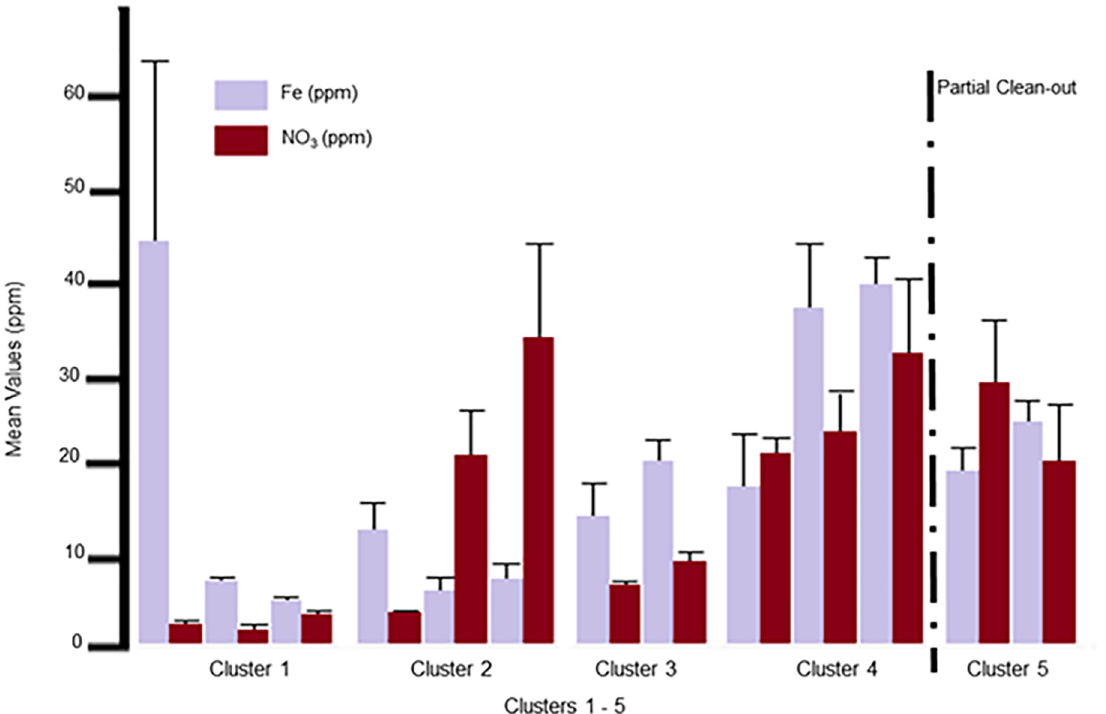
Fig 2. Mean values for the parameters Fe and NO 3 . Mean values for the parameters Fe and NO 3 expressed as ppm, with standard deviation error bars are shown in this graph. In order from left to right on the graph is Cluster 1: Native, Pad and Flock1; Cluster 2: Flock 2, 10 and 11; Cluster 3: Flocks 3 and 4; Cluster 4: Flocks 5, 6, and 7; and Cluster 5: Flocks 8 and 9. The partial clean-out which occurred between Flock 7 and 8 is marked by a dashed